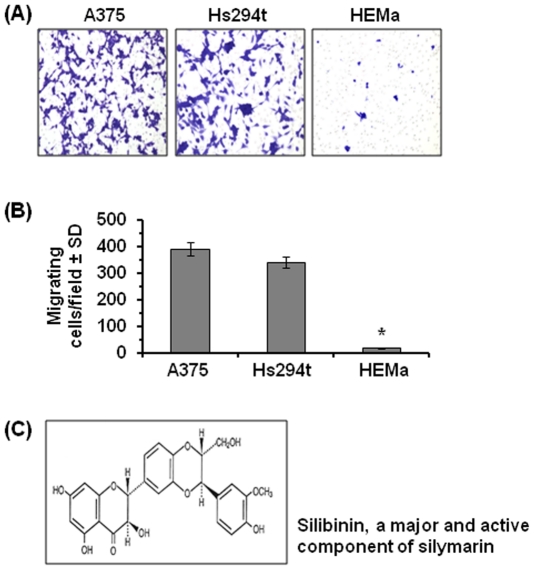
Migration ability of human melanoma cells and normal human epidermal melanocytes.(A) Equal numbers of human melanoma cells (A375 and Hs294t) and normal human epidermal melanocytes (HEMa) were subjected to cell migration by standard invasion assay using Boyden chambers. Twenty four h later, migratory cells were detected on the membrane after staining the migratory cells with the 0.1% crystal violet dye. Representative photomicrographs are shown from three independent experiments. (B) The migratory cells were counted and the results expressed as the mean number of migratory cells ± SD per microscopic field (n = 3). Significantly less migration of normal human melanocytes versus melanoma cells, *
P<0.001. (C) Chemical structure of silibinin, the major and most biological active component of silymarin.